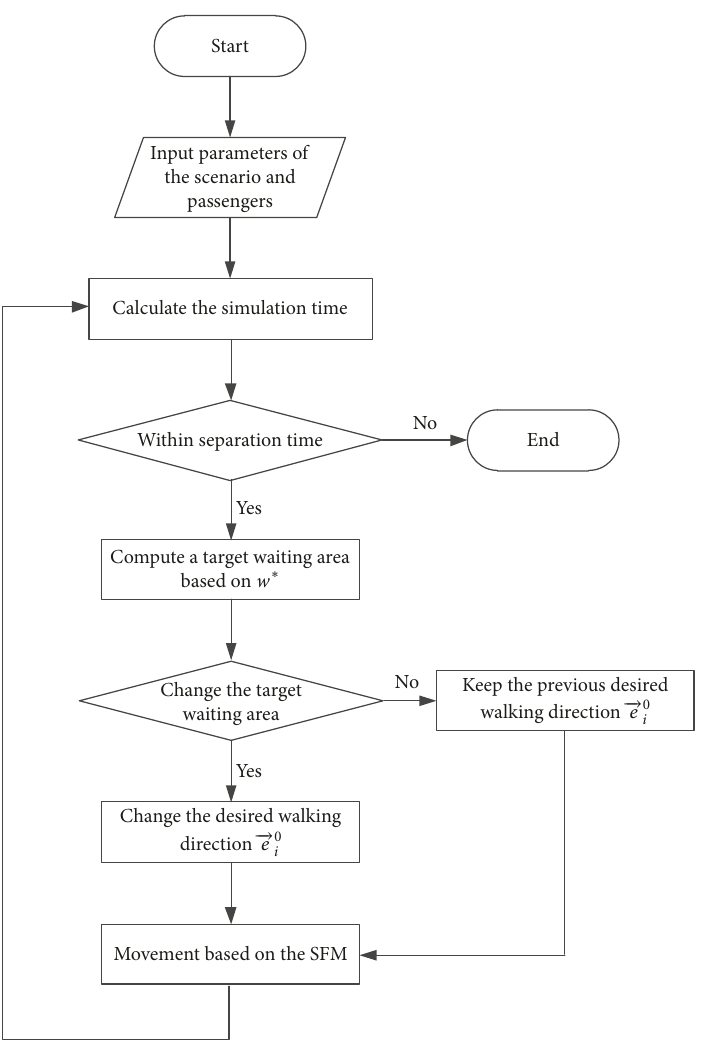
Figure 6: The flow diagram of the passenger movement process at the